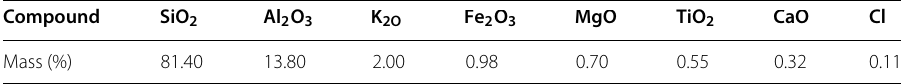
Table 4 The results of X-ray fluorescence (XRF) analysis of Berea sandstone Compound